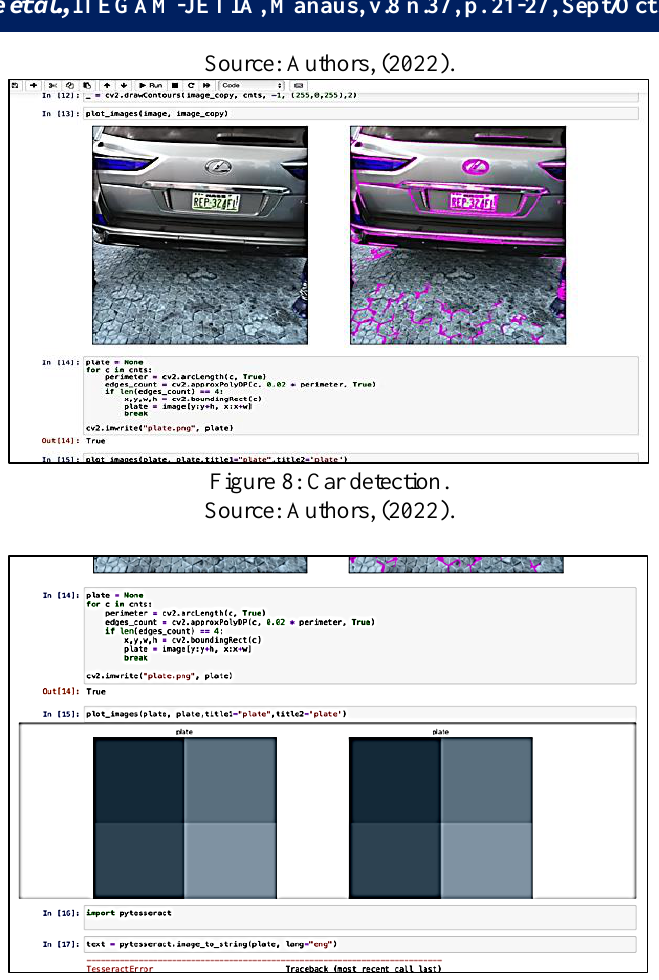
Figure 9: Image of a vehicle not successfully detected.